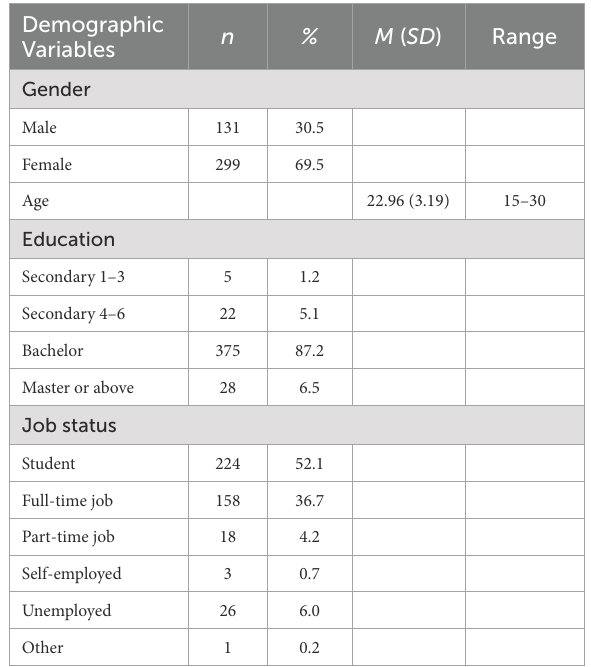
TABLE 1 Major characteristics of